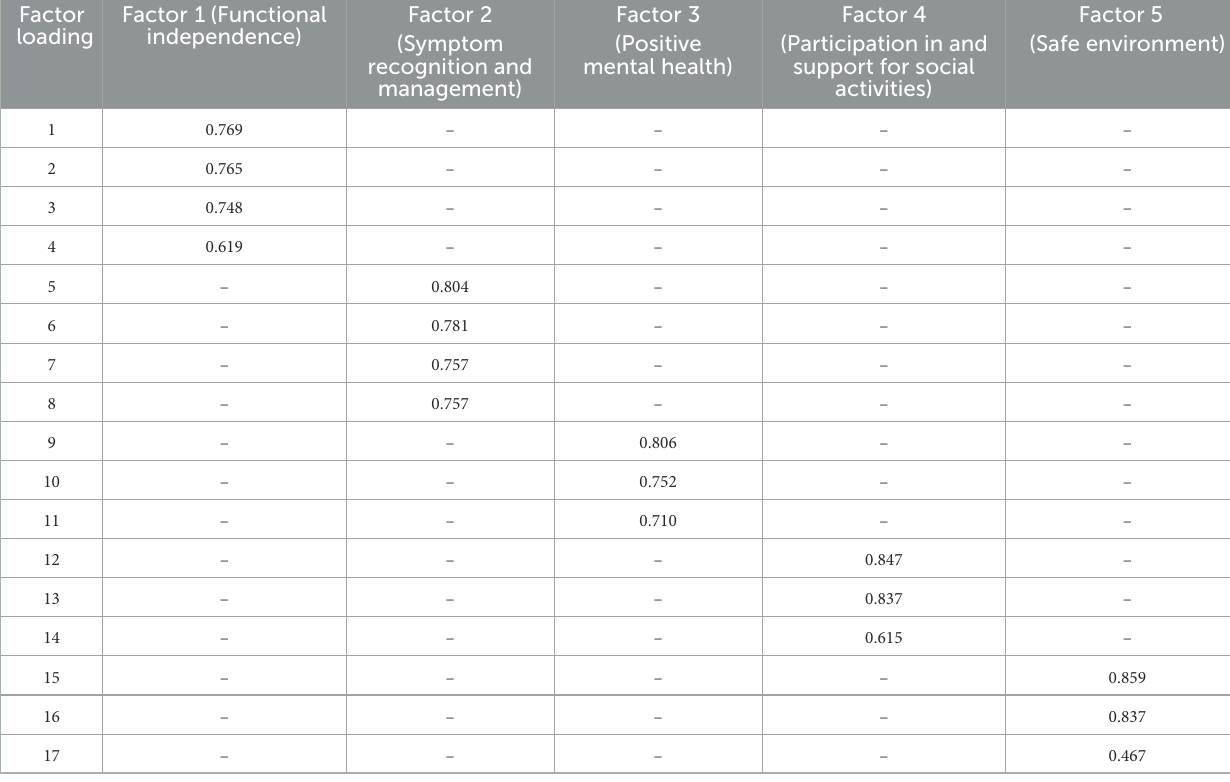
TABLE 3 Factor loadings of exploratory factor analysis for Chinese version of the self-care scale for older adults undergoing hip fracture surgery. Factor